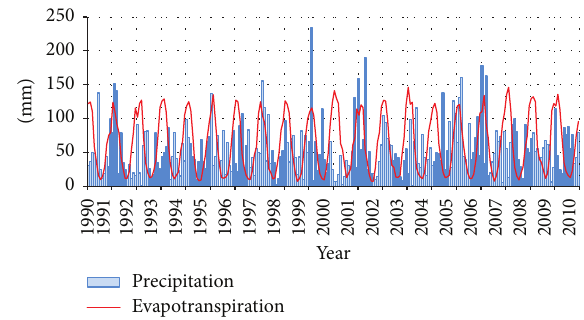
Figure 2: Monthly precipitation ( 𝑃 ) and evapotranspiration (ETo) versus time in period 1990–2010.